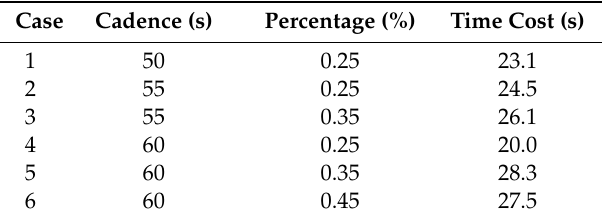
Table 9. Duration of the pre-validation processes with 1 neuron and delay 1.